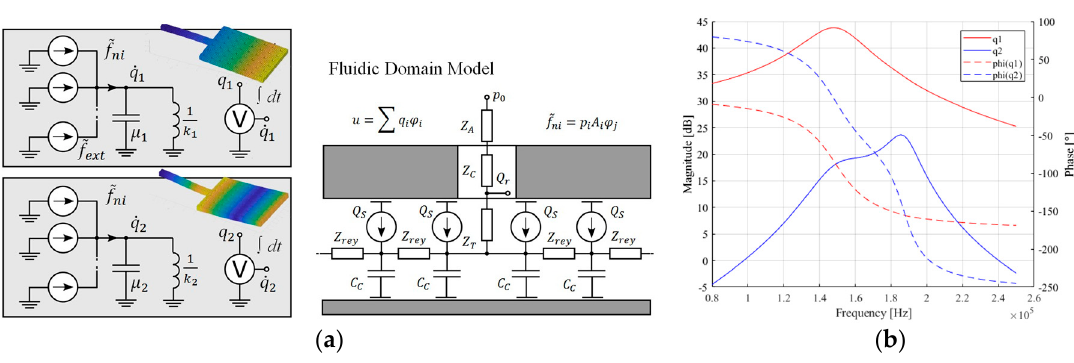
Figure 2. Lumped flow resistance model. ( a ) Schematic representation of the lumped flow resistance network model. ( b ) Modal interaction in frequency